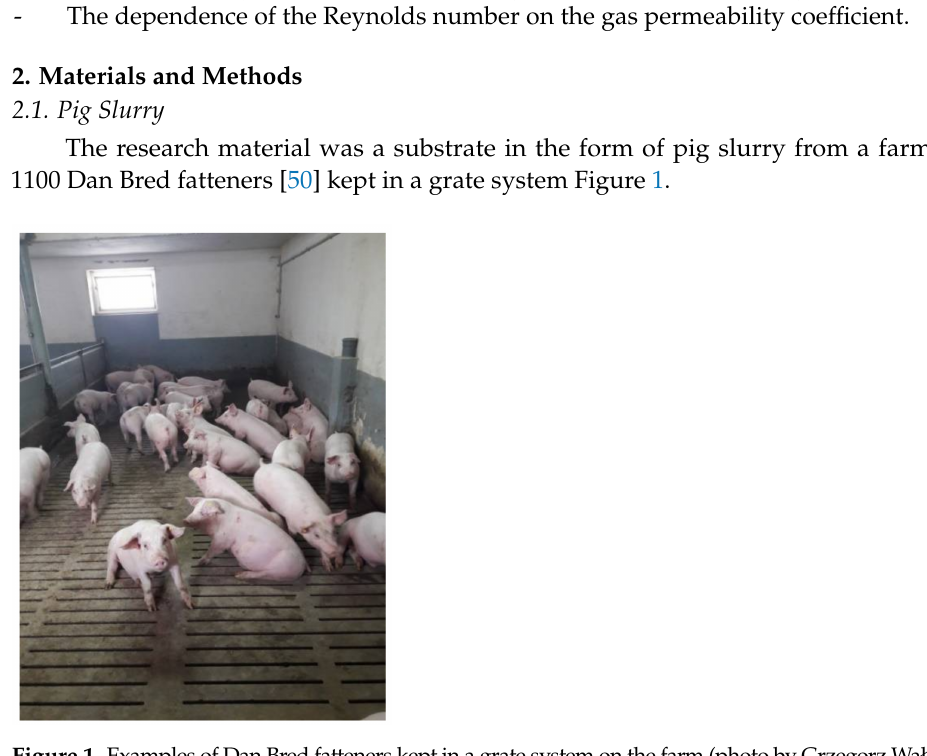
Figure 1. Examples of Dan Bred fatteners kept in a grate system on the farm (photo by Grzegorz Wałowski).